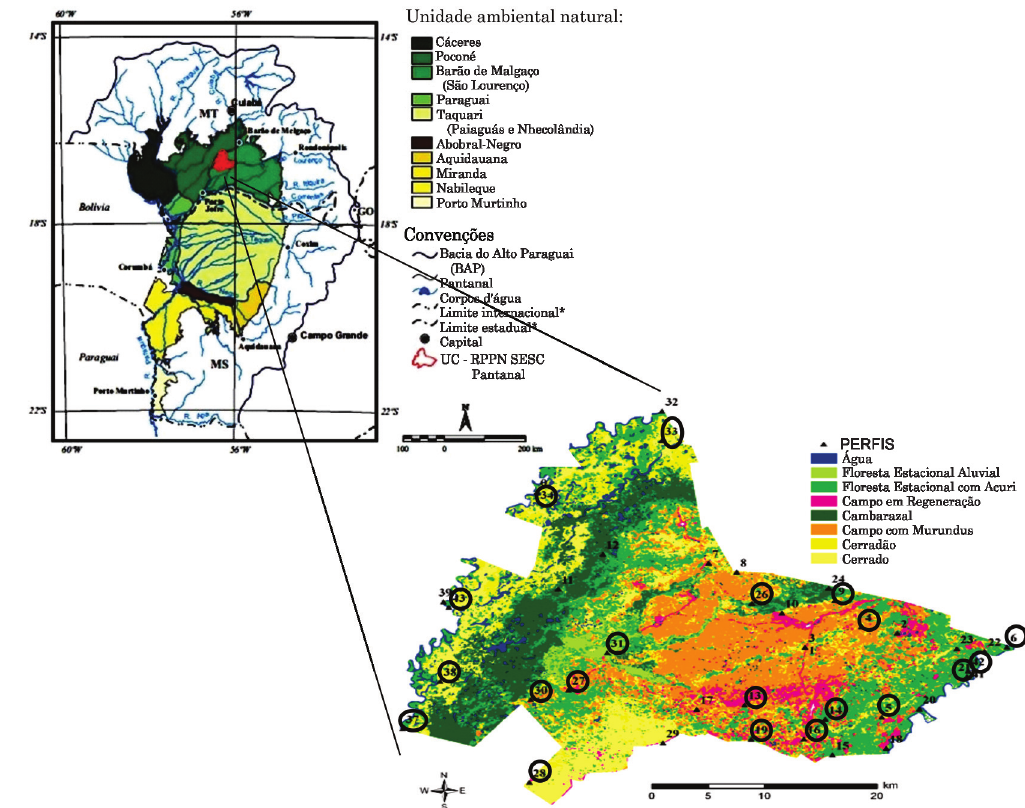
Figura 1. Localização da área de estudos; (a) Sub-regiões do Pantanal e Bacia do Alto Paraguai (b) RPPN SESC Pantanal com suas fitofisionomias vegetais e pontos de amostragem. Fonte: Cordeiro (2004) e Beirigo et al.